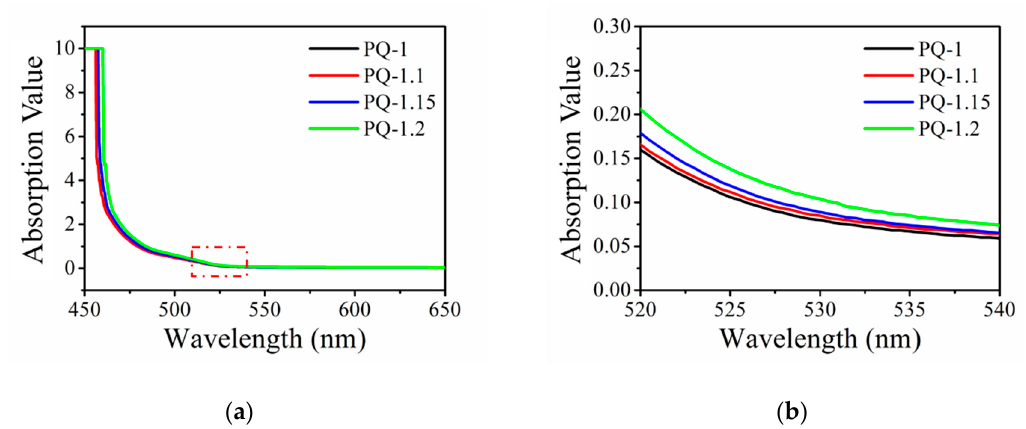
Figure 2. ( a ) UV–visible absorption spectrum of SiO 2 NP-PQ / PMMA sample; ( b ) partially amplified UV–Vis absorption spectrum.